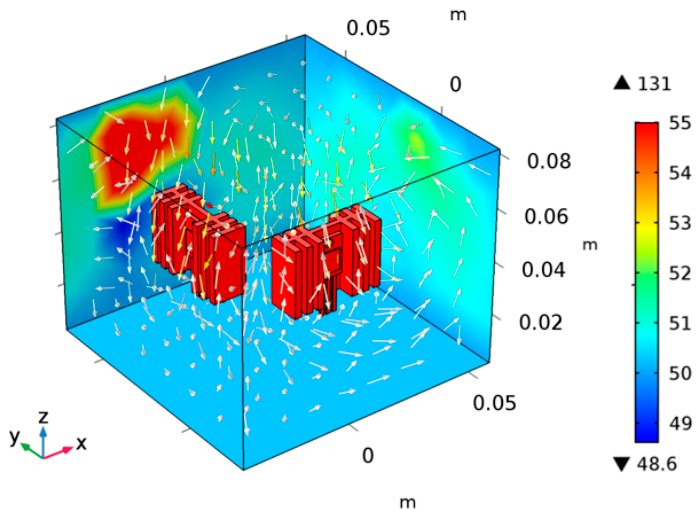
Figure 12. The temperature distribution of convection thermal coupling. Through the FEM analysis, the temperature distribution and iso-surface distribution of power devices under di ff erent ambient temperatures are obtained, as shown in Figure 13. In the fi gures below, the color tables show the di ff erence in the distribution.